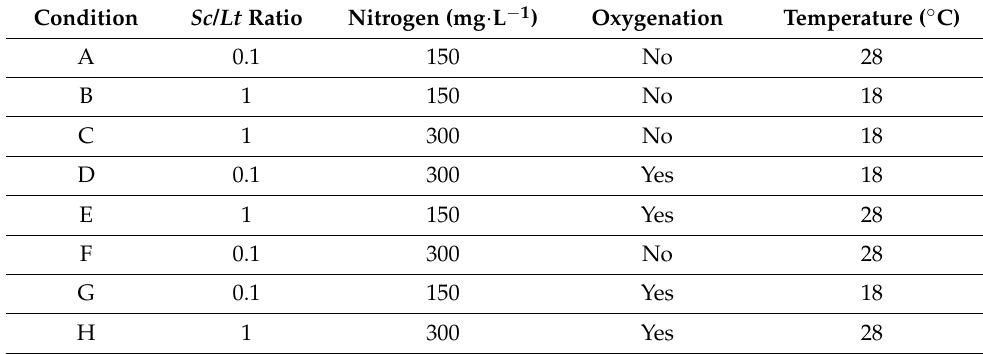
Table 2. Conditions tested in the experimental design and corresponding